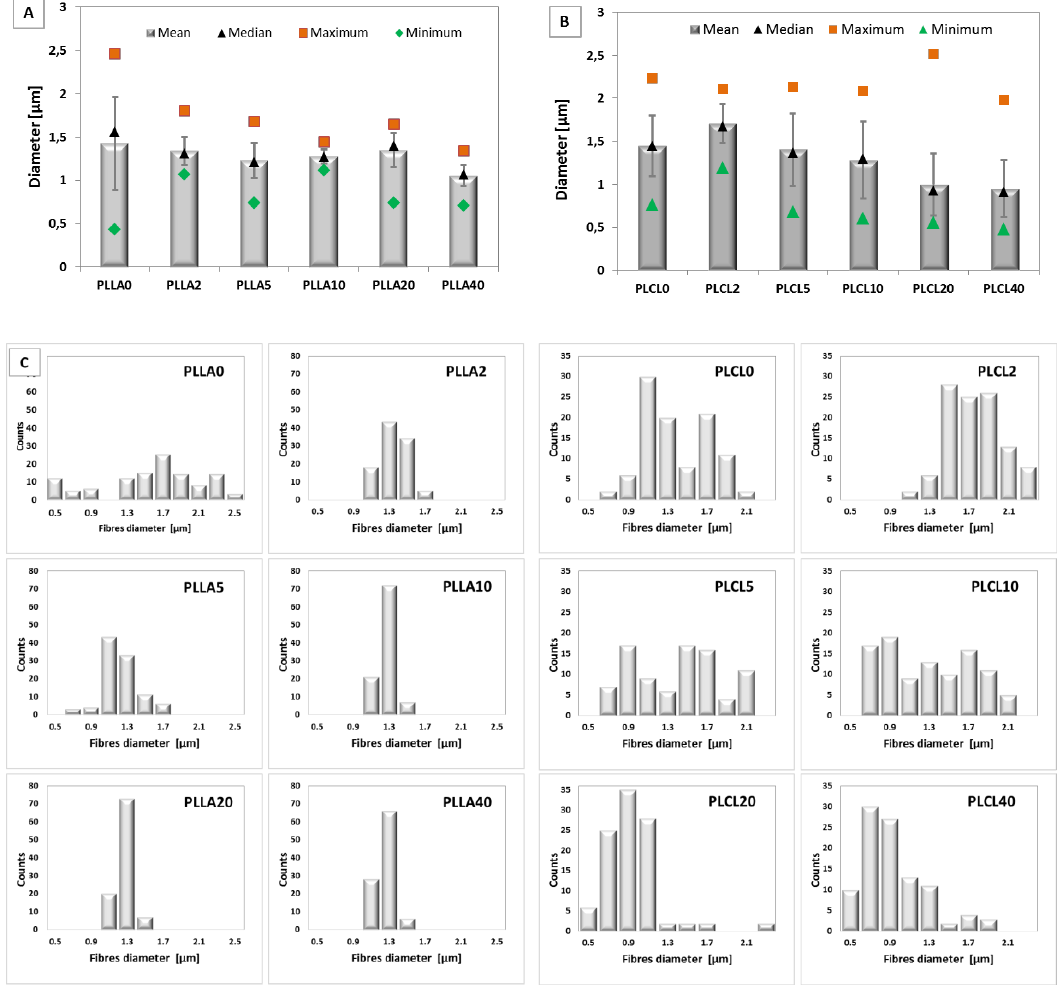
Figure 5. Diameter of electrospun bicomponent fibres with PGSu additive: ( A ) PLLA2, PLLA5, PLLA10, PLLA20, and PLLA40 in relation to PLLA0 (pure PLLA); ( B ) PLCL2, PLCL5, PLCL10, PLCL20, and PLCL40 in relation to PLCL0 (pure PLCL) determined with SEM images; ( C ) histograms of all fibre